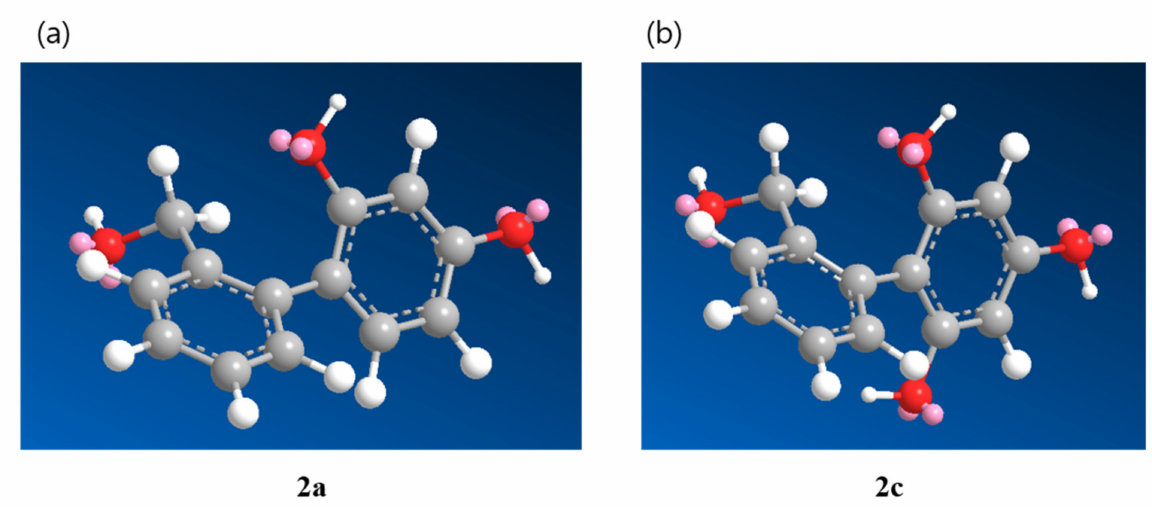
Figure 3. The most stable conformers of compounds ( a ) 2a and ( b ) 2c. These conformers were obtained by MM2 energy minimization using Chem3D Pro